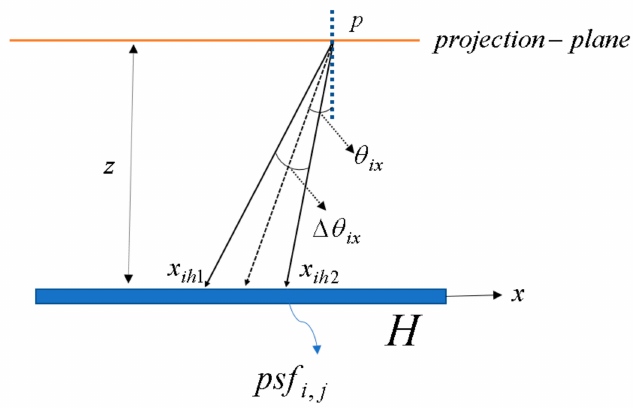
Figure 2. The hologram projection angle and